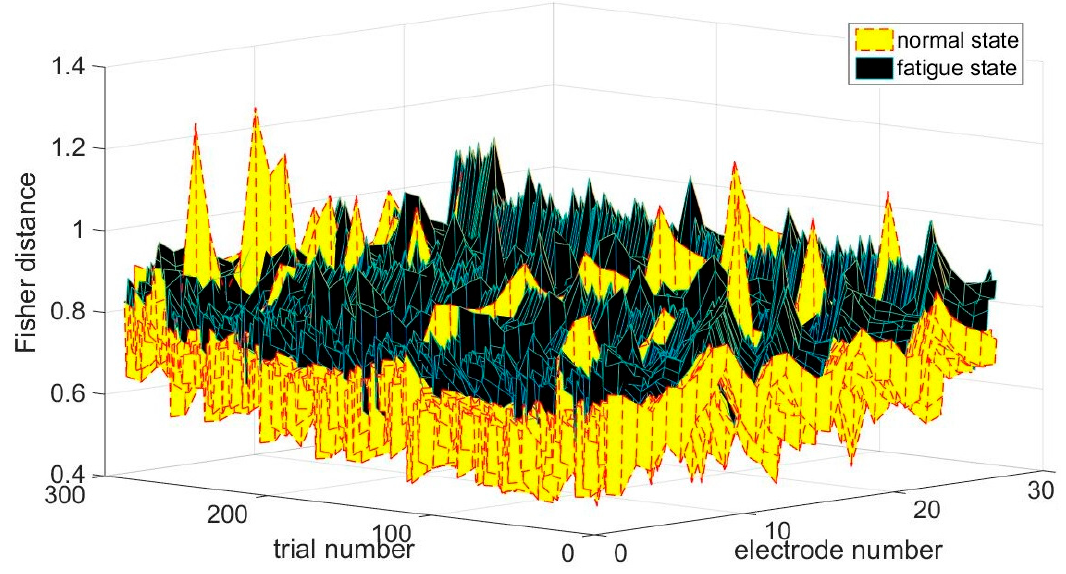
Figure 4. The comparison of Fisher distance on fuzzy entropy among multiple samples in two states.